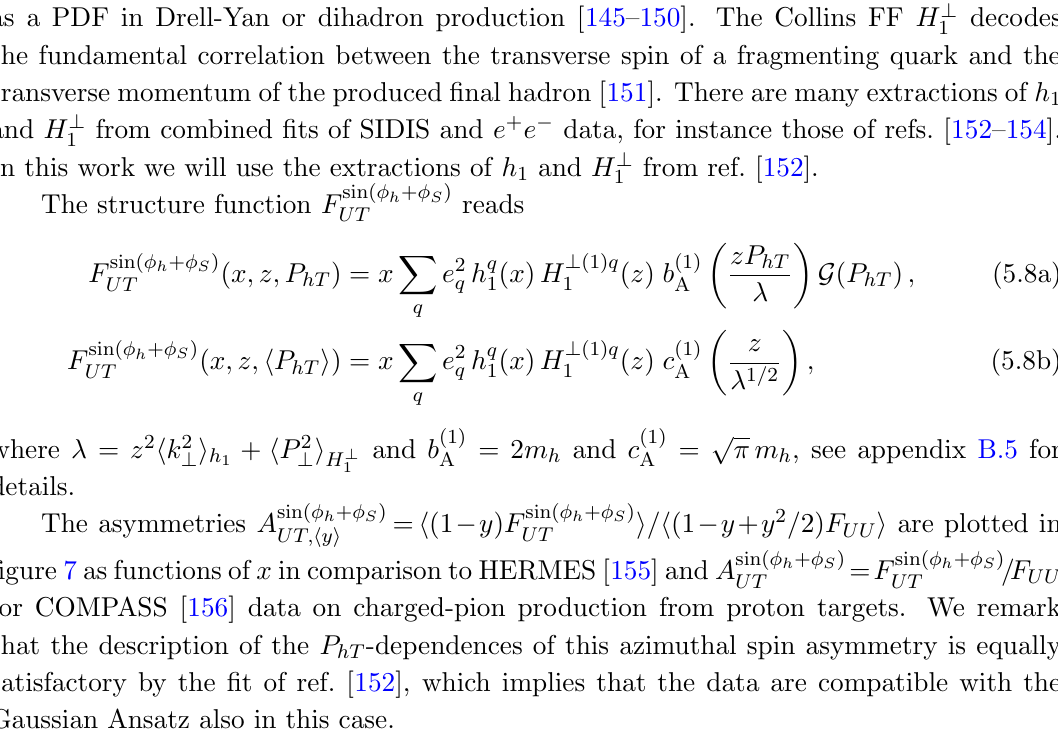
Figure 7. Collins asymmetry for a proton target vs x based on the (cid:12)t [152]. (a) A sin( (cid:30) h + (cid:30) S ) comparison to HERMES [155] data. (b) A sin( (cid:30) h + (cid:30) S )